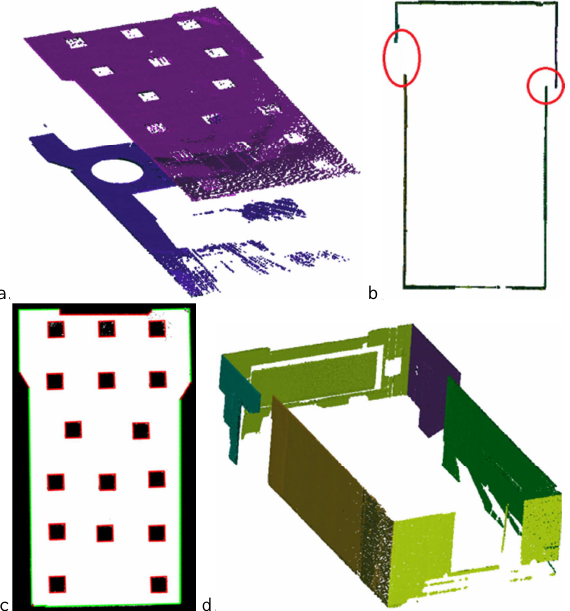
Figure 4. Detection of room surface for ‘Classroom’ data set: (a) detected ceiling and floor; (b) some wall portions are missing (in red circles) due to occlusions; (c) binary occupancy raster map of the ceiling with walls (green segments) and spurious boundaries (red segments); and (d) detected wall surfaces.